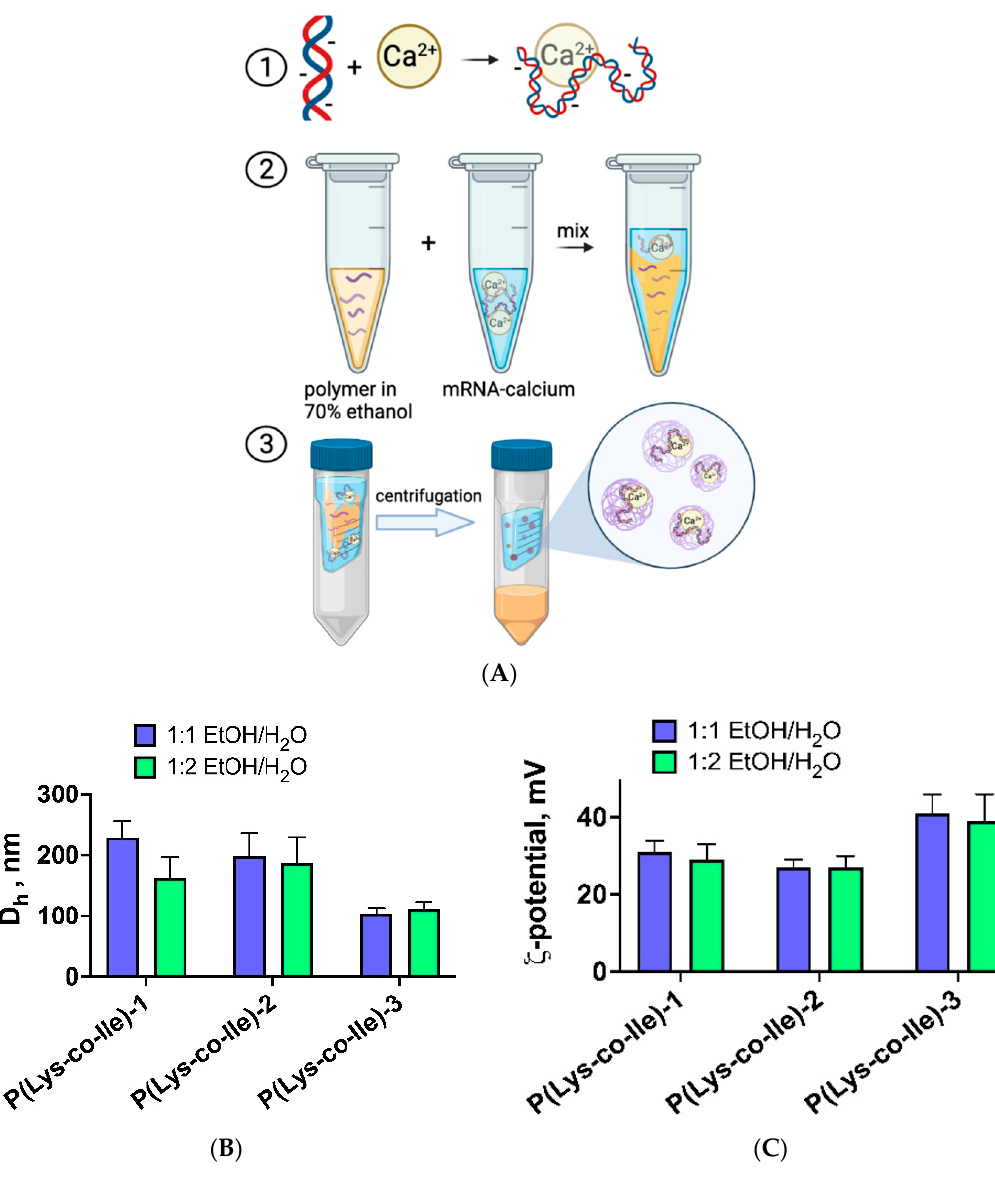
Figure 5. Encapsulation of mRNA via phase inversion: general idea of the method ( A ); size ( B ) and ζ -potential ( C ) of polyplexes obtained at different ethanol/water ratios. N/P ratio was fixed at 4 in these experiments. The measurements were performed in ultrapure H 2 O. Results are given as Mean ± SD ( n = 3).